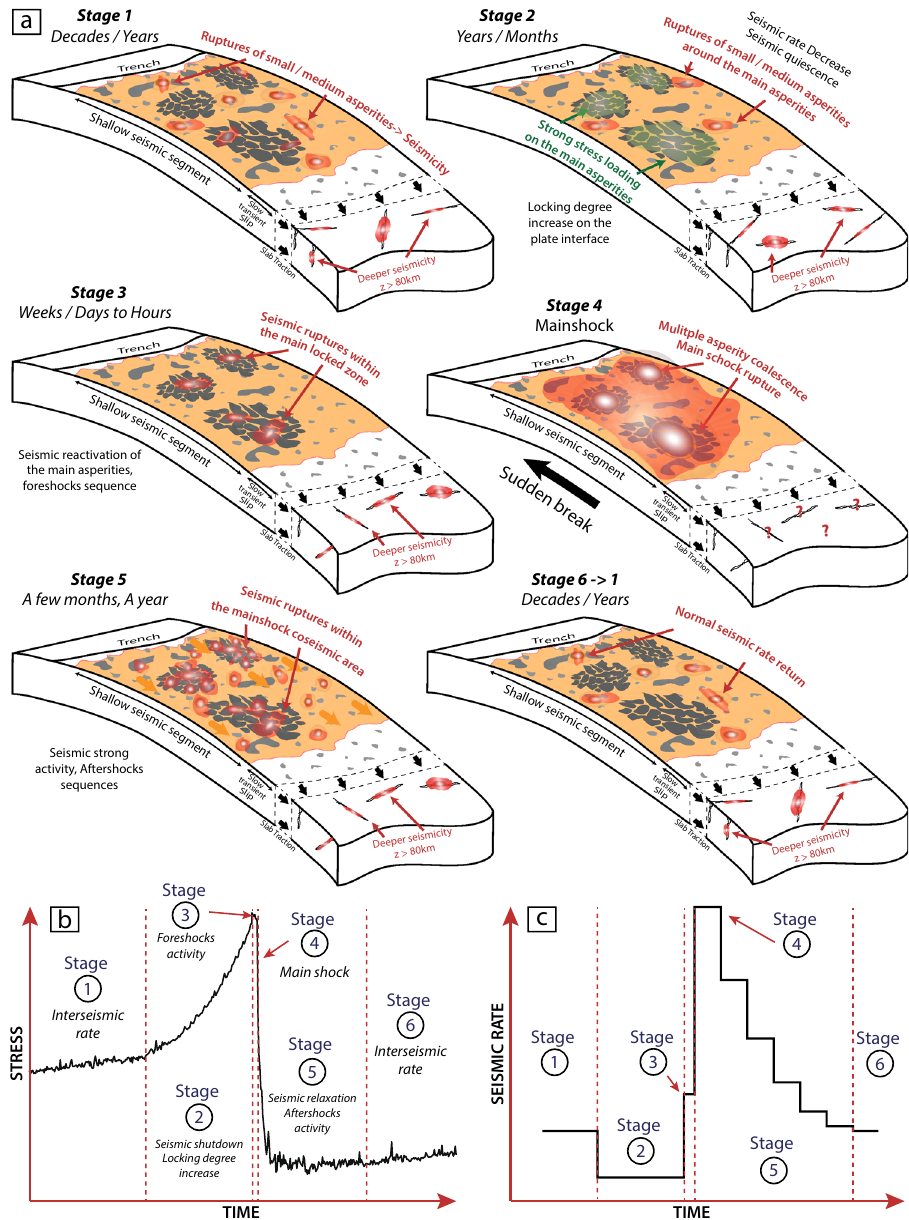
Figure 6. General scheme of the seismic processes before the Maule main shock. ( a ) Stage 1 corresponds to the normal seismic rate connected to the continuous slab traction on the locked zone (…–2007). On Stage 2 the seismic rate decreases, and very few events with M > 5 are observed within the future rupture zone (2007–2010). The locking degree increases at the interface, and the stress strongly increases on the main asperities. Stage 3 corresponds to the foreshock phase occurring a few days before the main shock. This activity occurred close to the areas where the maximum co-seismic slip were observed, indicating the maturity of the main asperities to fail soon, and Stage 4 images the main shock occurring on 27 February 2010. On Stage 5, numerous aftershocks occur during the early relaxation phase within the main shock rupture zone, before the main asperities grip again, increasing the local locking degree. Stage 6. At this stage, the seismic rate reaches its steady-state, going back to the first stage. ( b ) Conceptual scheme of the stress change on the plate interface during the seismic cycle of the M W 8.8 Maule earthquake. ( c ) Conceptual scheme of the seismic rate